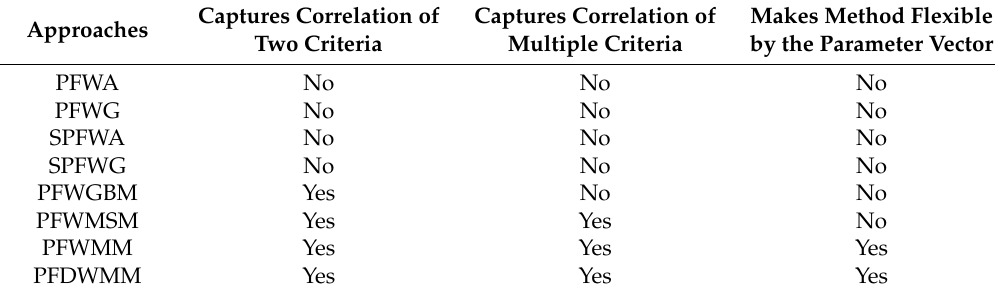
Table 14. A comparison of the different